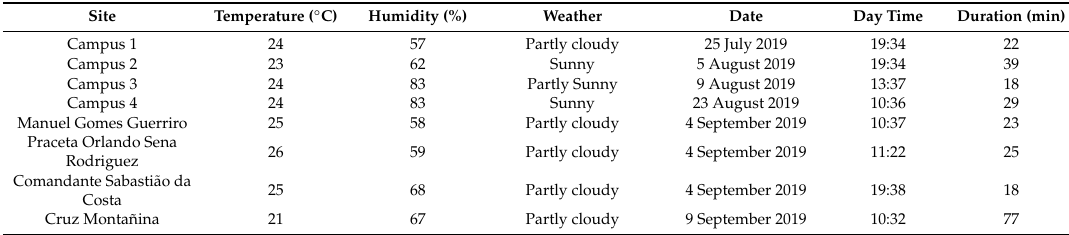
Table 3. Weather and temporal conditions of data